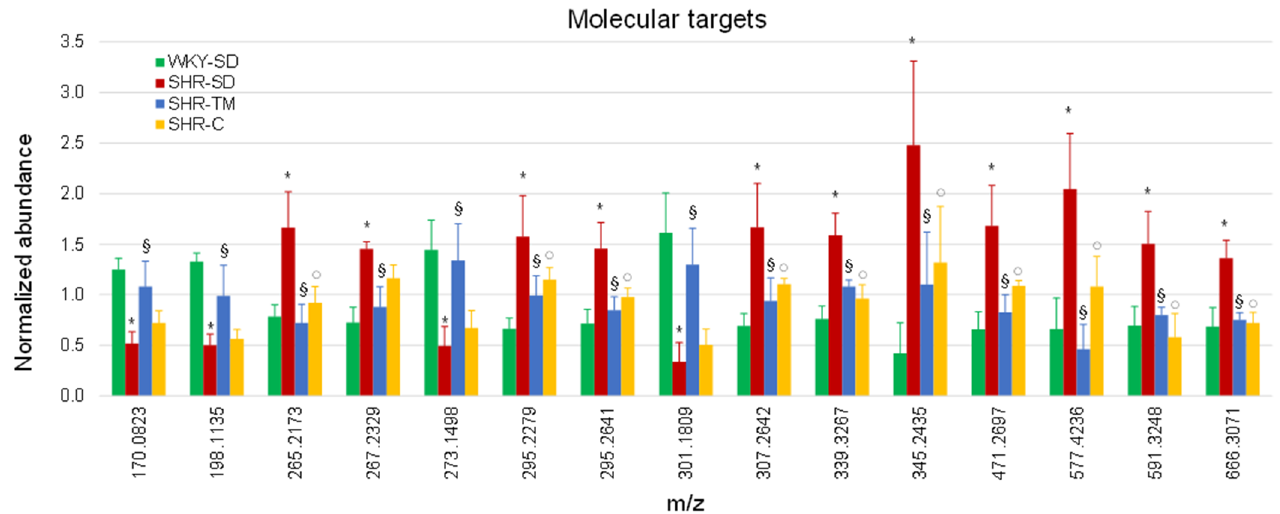
Figure 3. Bar diagram reporting normalized intensity values of metabolite markers of hypertension reversed by supplementation with TM protein extract. * SHR-SD vs. WKY-SD, p < 0.05; § SHR-SD vs. SHR-TM, p < 0.05; ° SHR-SD vs. SHR-C, p < 0.05, one-way ANOVA.